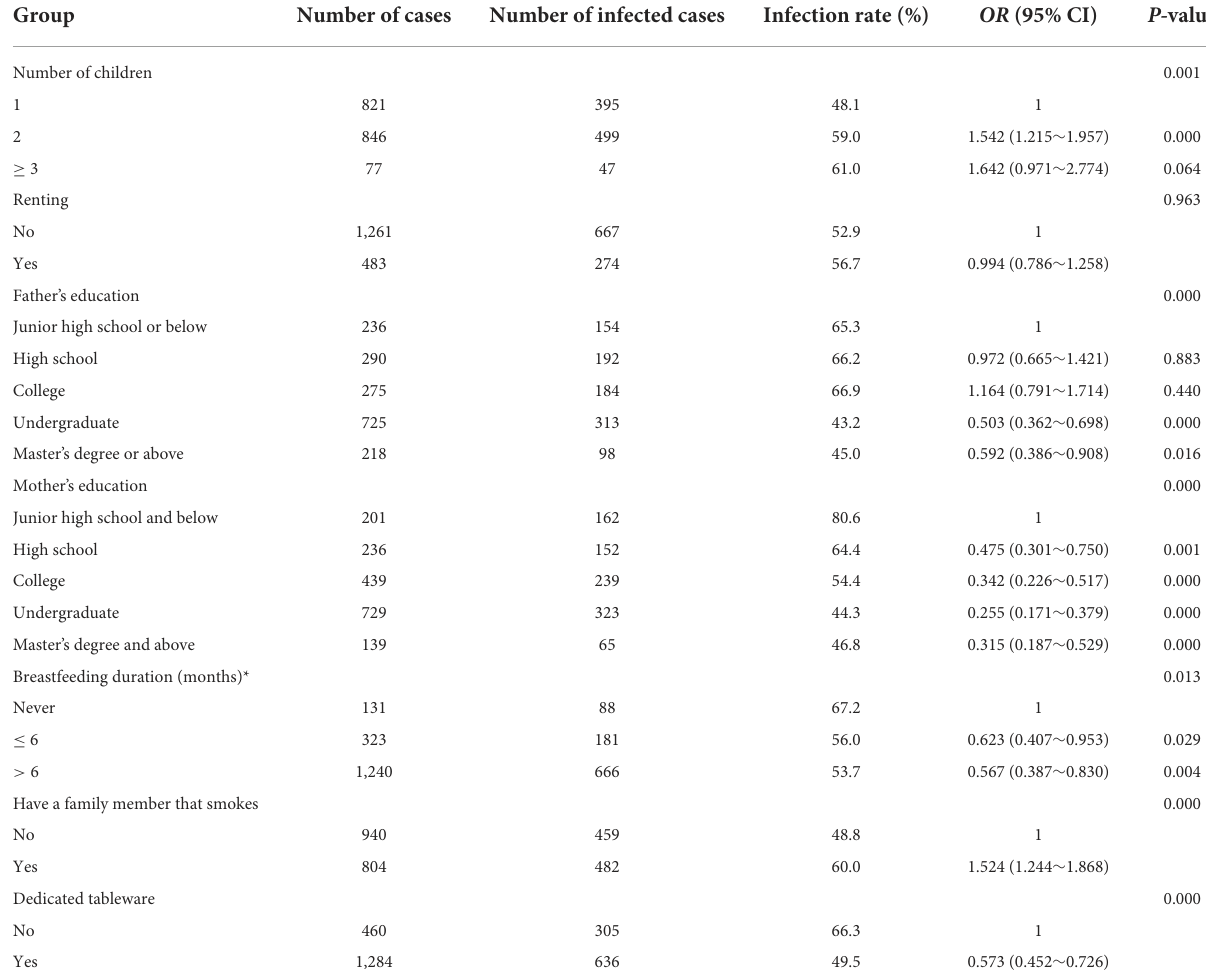
TABLE 4 Multivariate logistic regression of EBV infection risk based on participant characteristics. Group Number of cases Number of infected